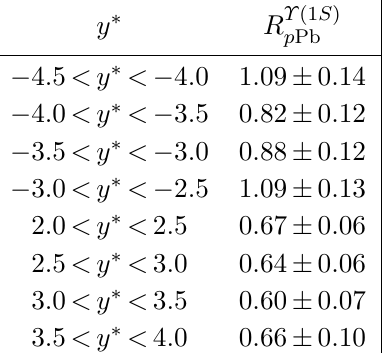
, in p Pb and Pb p as a function of y (cid:3) integrated p Pb